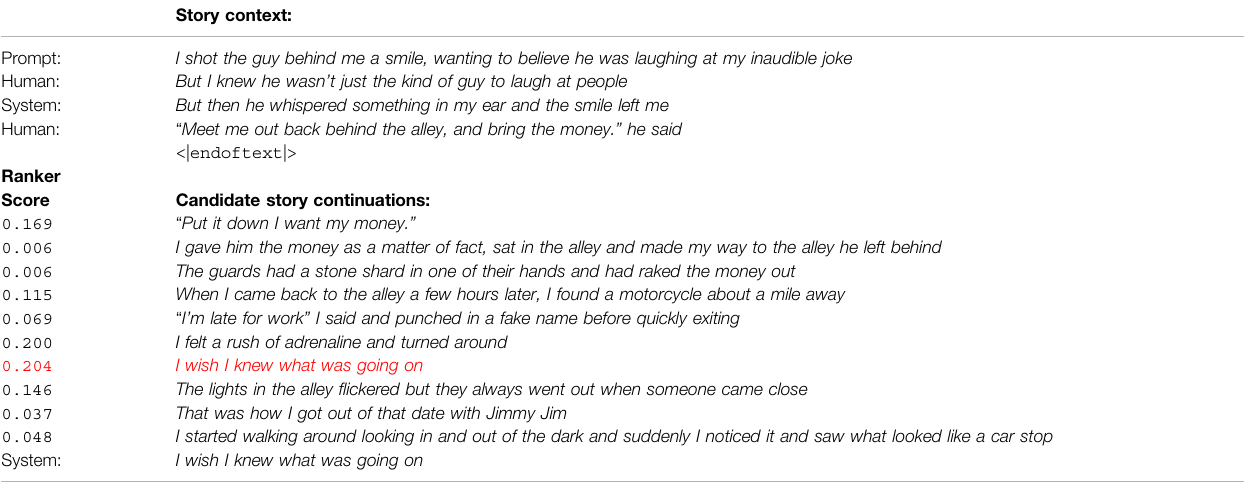
TABLE 3 | An example of the collaborative story generation